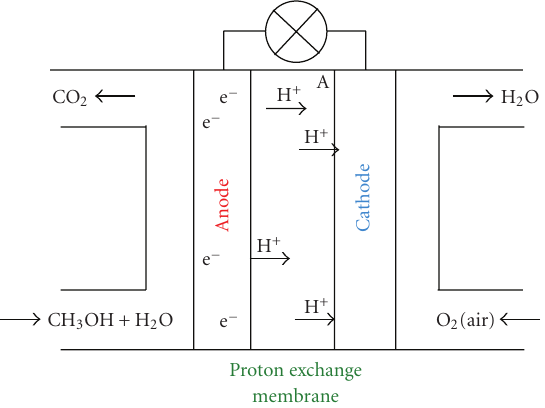
Figure 1: Schematic diagram illustrating the operating principle of a direct methanol fuel cell